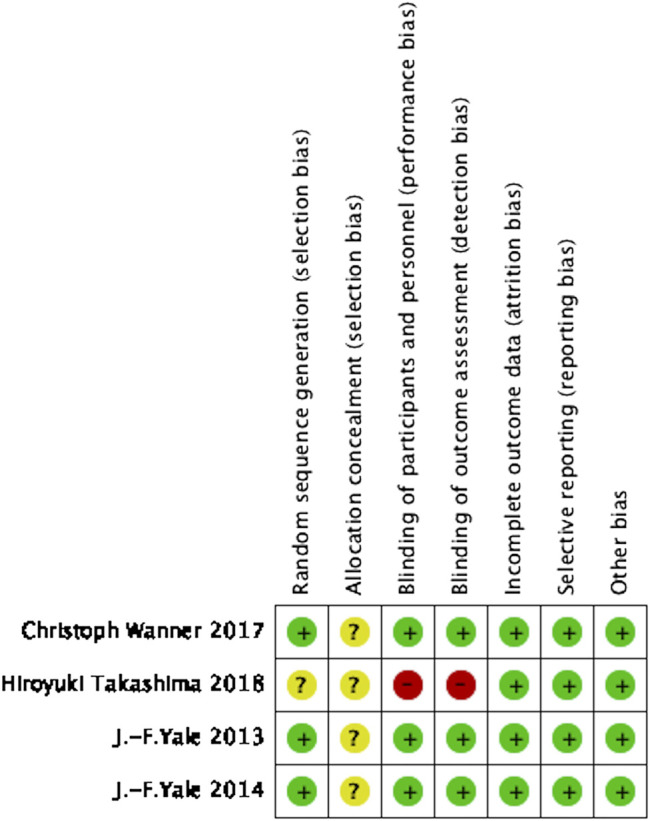
Risk of bias in the included studies.